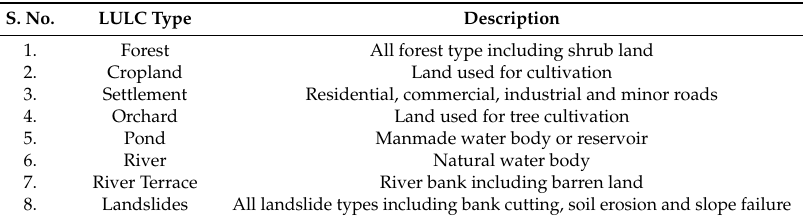
Table 1. Land use classification.